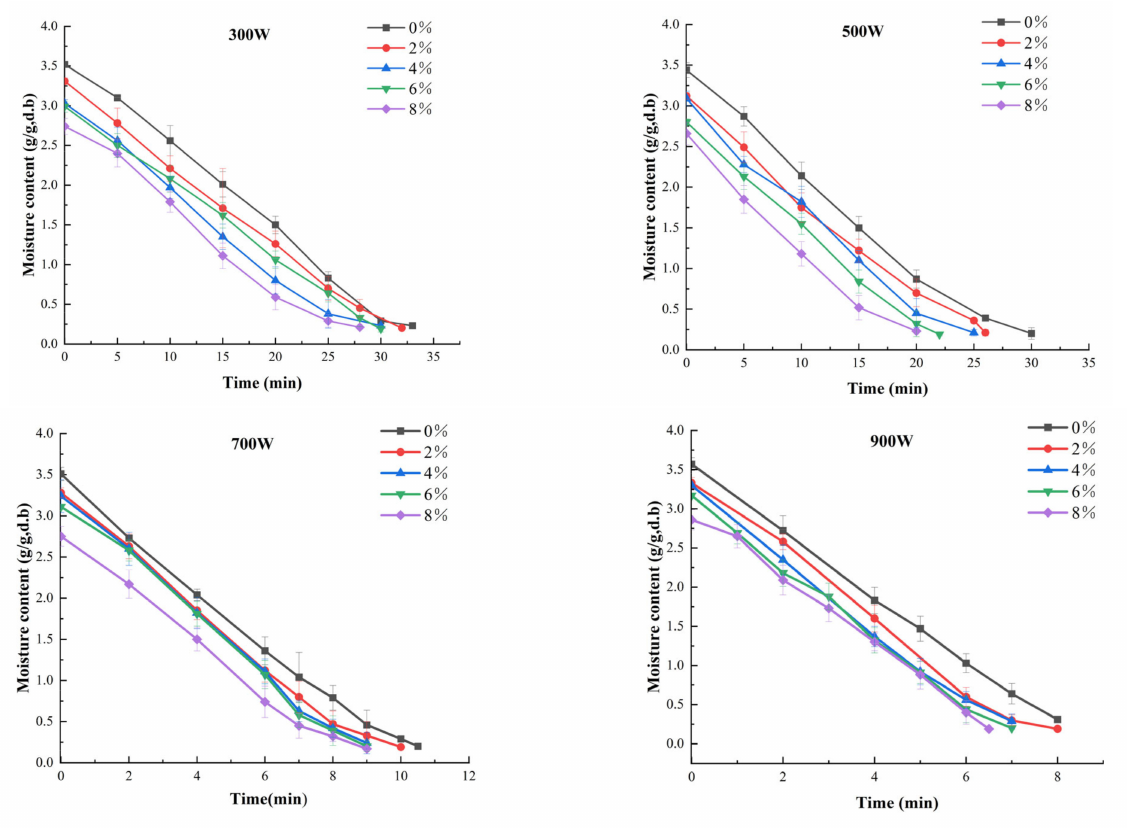
Figure 1. Effect of different salt concentrations and microwave power on drying rate of white